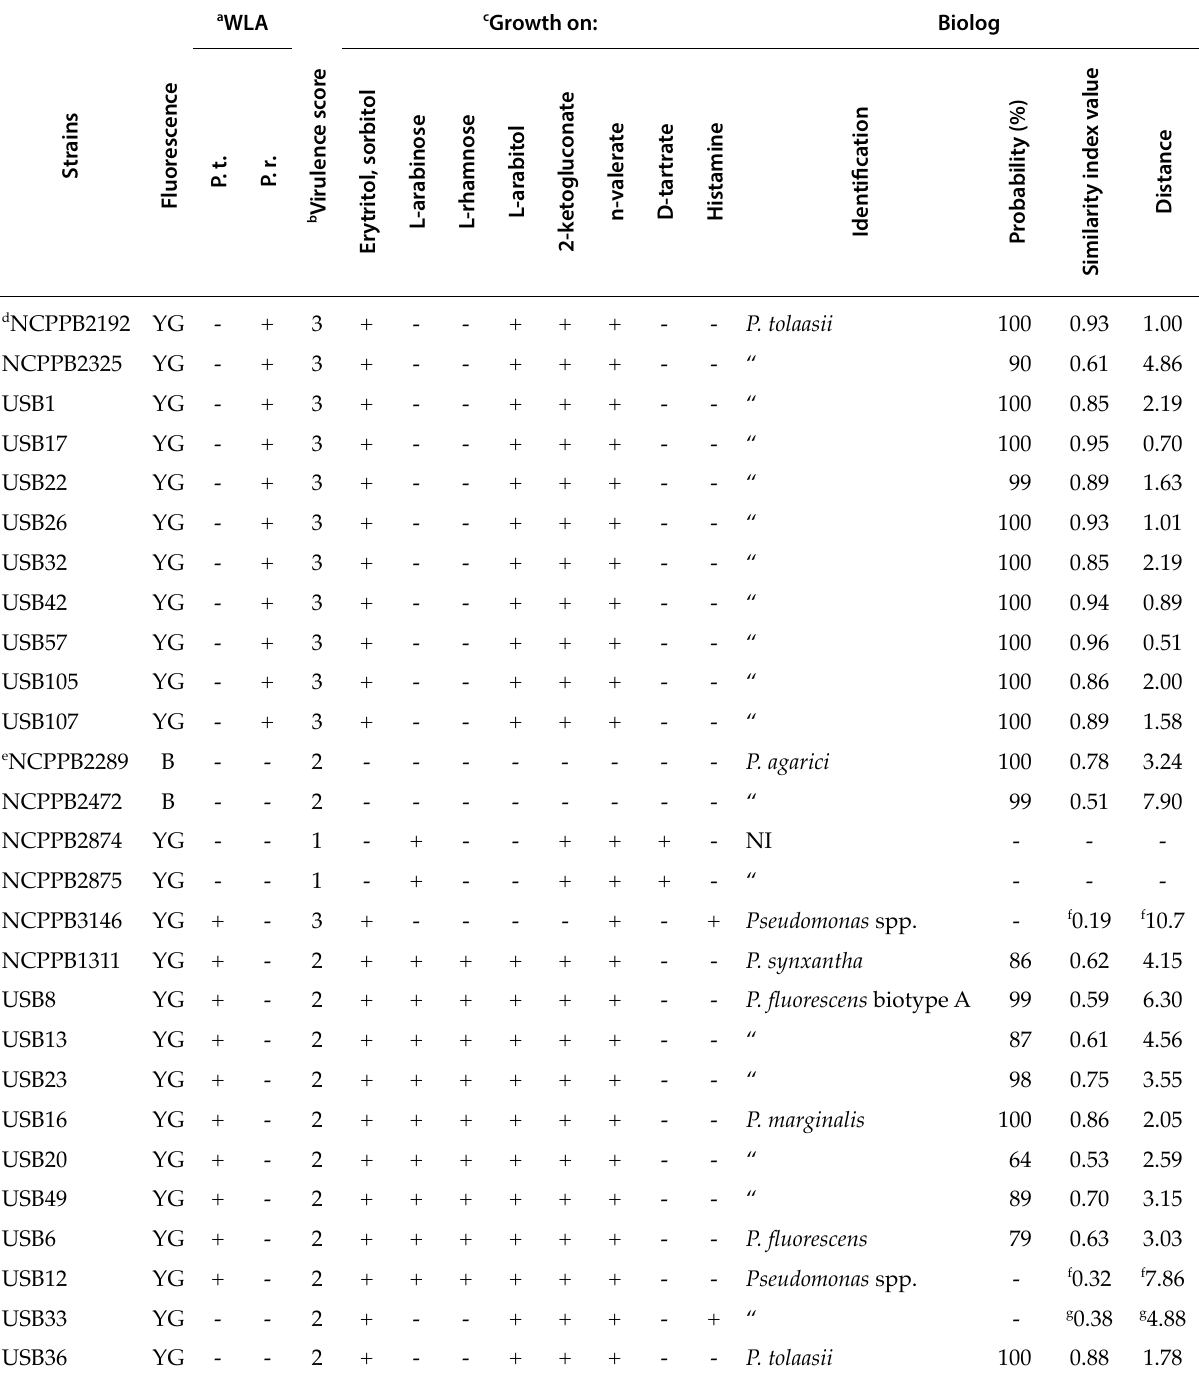
Table 3 . Biochemical and nutritional characters and virulence of selected bacterial isolates obtained from lesions on Pleu- rotus ostreatus